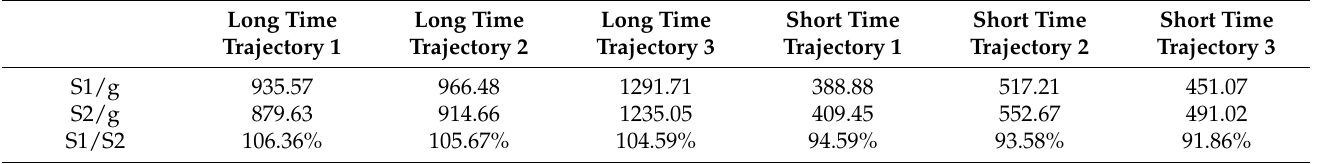
Table 5. Total fuel consumption of single